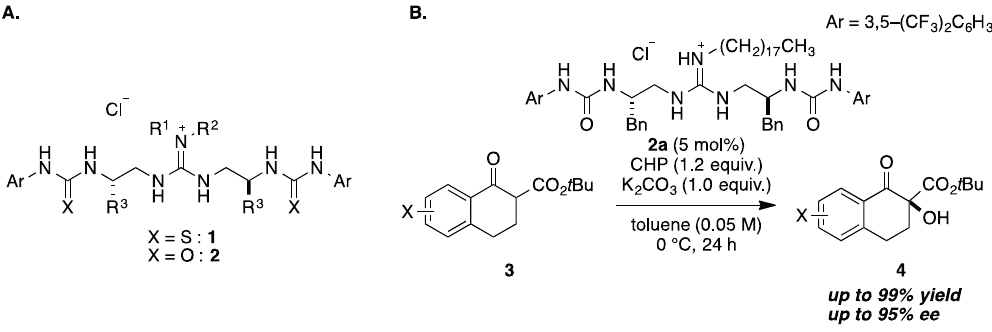
Figure 1. ( A ) Structures of guanidine-bis(thio)urea bifunctional organocatalysts 1 and 2 ;